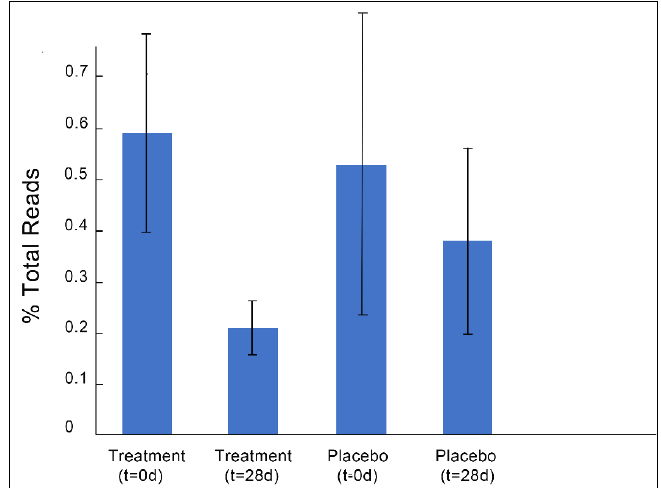
Figure 2. ( A ) Percent of total reads represented by amplicon sequence variants (ASVs) mapping to Escherichia. coli for each treatment and time point. ( B ) Change in E. coli levels from baseline values after treatment or placebo consumption. Data represents only individuals with baseline E. coli levels ( n = 21). Error bars represent SEM.